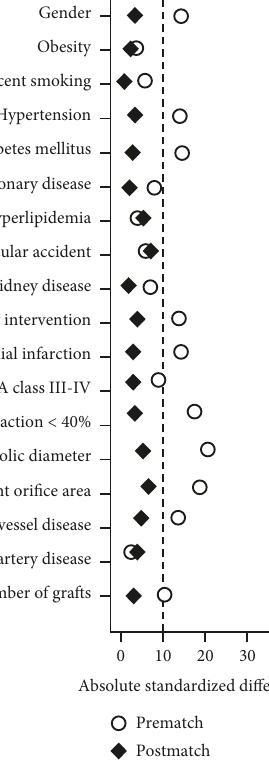
Figure 2: Absolute standardized differences for baseline covariates before and after matching. NYHA, New York Heart Association Functional